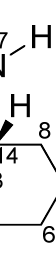
− )-morphinan Figure 1. The ( − )-morphinan skeleton. Figure 1. The (